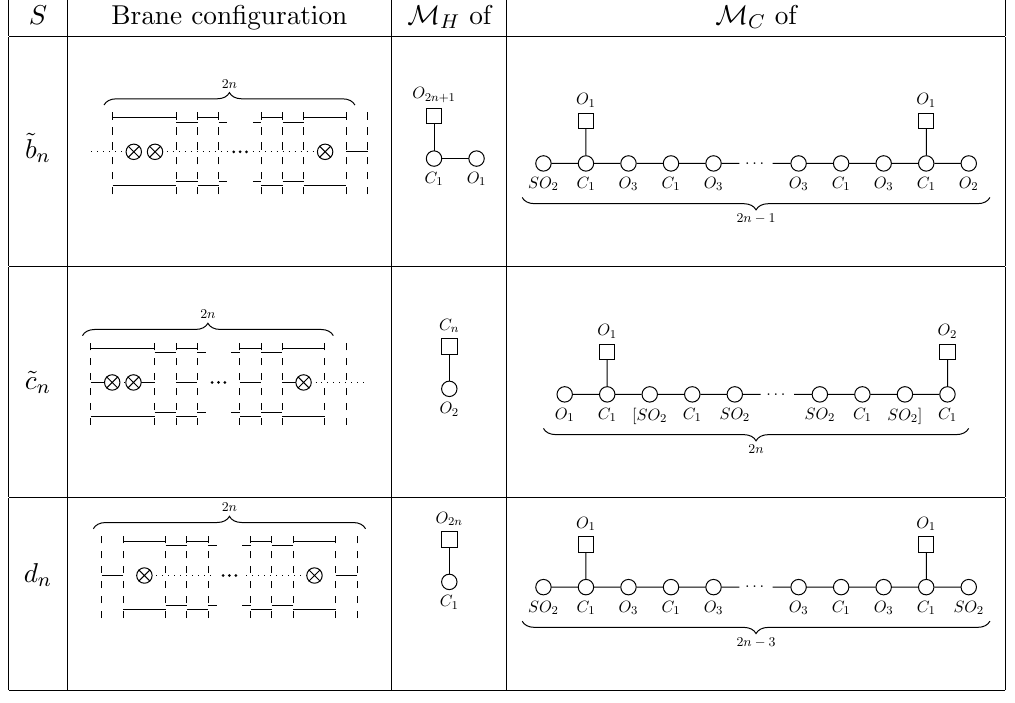
Table 7. Minimal KP singularites S and their brane con(cid:12)gurations. ~ b n denotes the closure of the next to minimal nilpotent orbit of so (2 n + 1), ~ c n denotes the closure of the next to minimal nilpotent orbit of sp ( n ) and d n is used for the closure of the minimal nilpotent orbit of so (2 n ). The second column shows their brane systems as Higgs branches. The third column shows the quivers obtained from the brane con(cid:12)gurations in the second column. The fourth column shows the quivers obtained after performing S-duality on the second column.